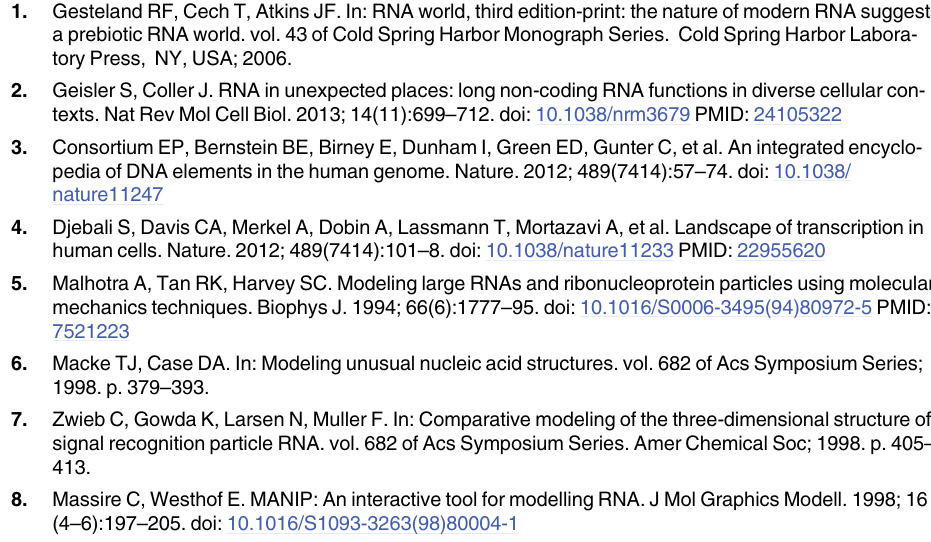
S1 Fig. Tertiary structure prediction for fragments in the RNA pseudoknot 1E95. (A) Sec- ondary structure of pseudoknot 1E95. (B) shows the RMSDs of predicted structures for all frag- ments of length 5, 8, and 10 in 1E95. The x-axis stands for the index of the first nucleotide of the tested fragment. S2 Fig. To estimate as to what percentage of genomic loop regions have no sequence homo- logs to structural templates, we calculated a quantity termed similarity probability for loops in the nine-loop testing set. For each loop (denotes as p ) in the nine-loop testing set, the quantity termed similarity probability is defined as the number of ( θ , η ) pairs in the loops of the same sequence as p in the templates over the total number of ( θ , η ) pairs in all the loops in the templates. As shown in the figure, the similarity probabilities are all less than 0.5%. Therefore, the presence of homologs has minimal effect on the conditional probability and hence the final prediction results. S1 Table. Values of coefficients k and b in Fig 2, the corresponding RMSE (root mean squared error) and